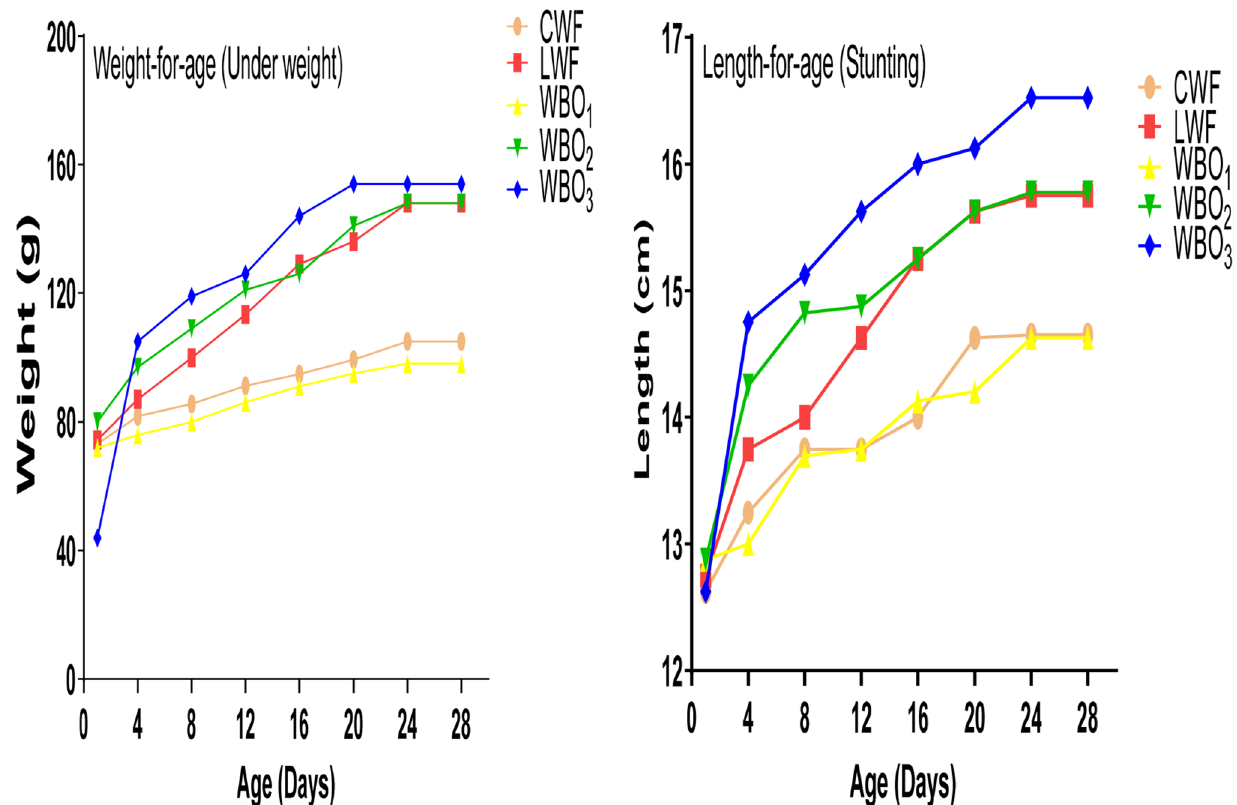
Fig. 3 Growth performance of rats fed on wheat-bambara ground- nut breads for 28 days. [75% wheat, 25% and bambara groundnut (WBO ); 50% wheat, and 50% bambara groundnut (WBO 1 Table 5 Biochemical parameters of wheat-bambara groundnut bread samples